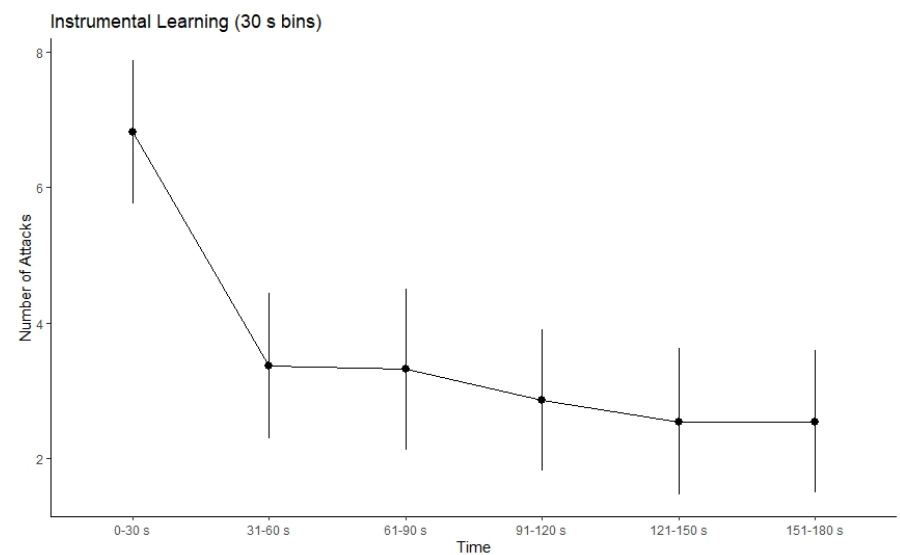
Figure 2. Number of attacks (30 s bins) during the instrumental phase. There was a significant decrease in the number of attacks from the first 30 s bin to the last 30 s bin ( p < 0.05), suggesting that participants learned the correct R-O contingencies. Error bars represent standard error of the mean.